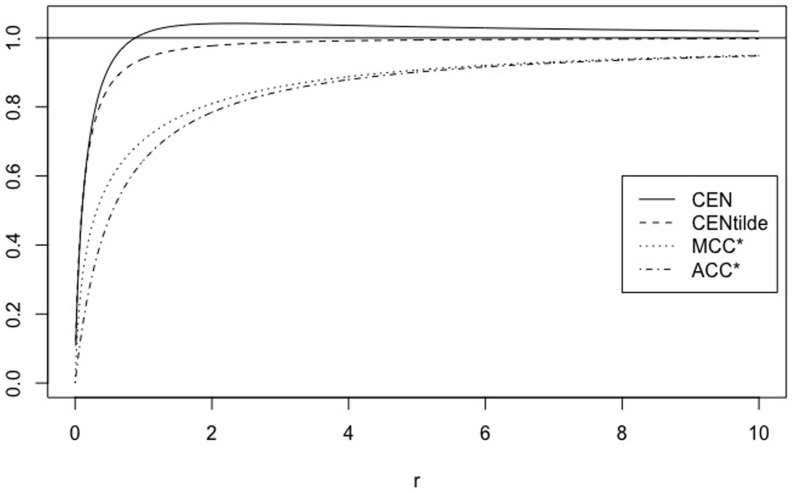
Family XA, r.CEN, MCEN, ACC* and MCC* as function of r > 0 for A = 10.